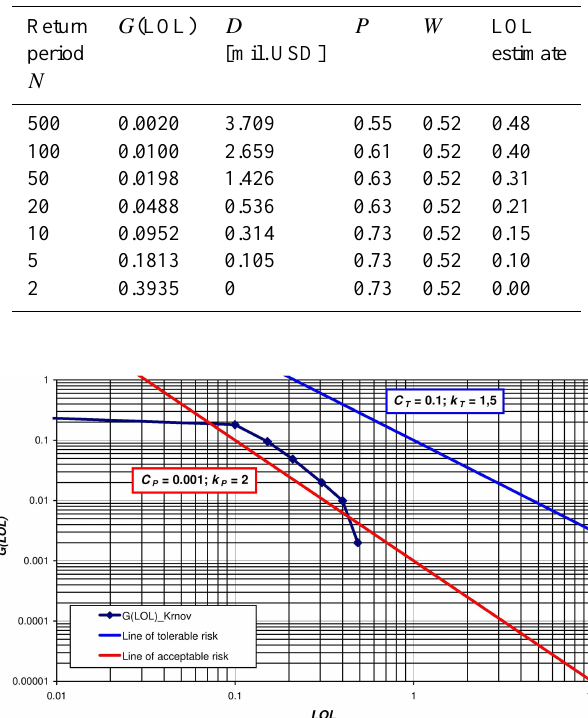
Table 9. Loss of life estimated for the Krnov locality.